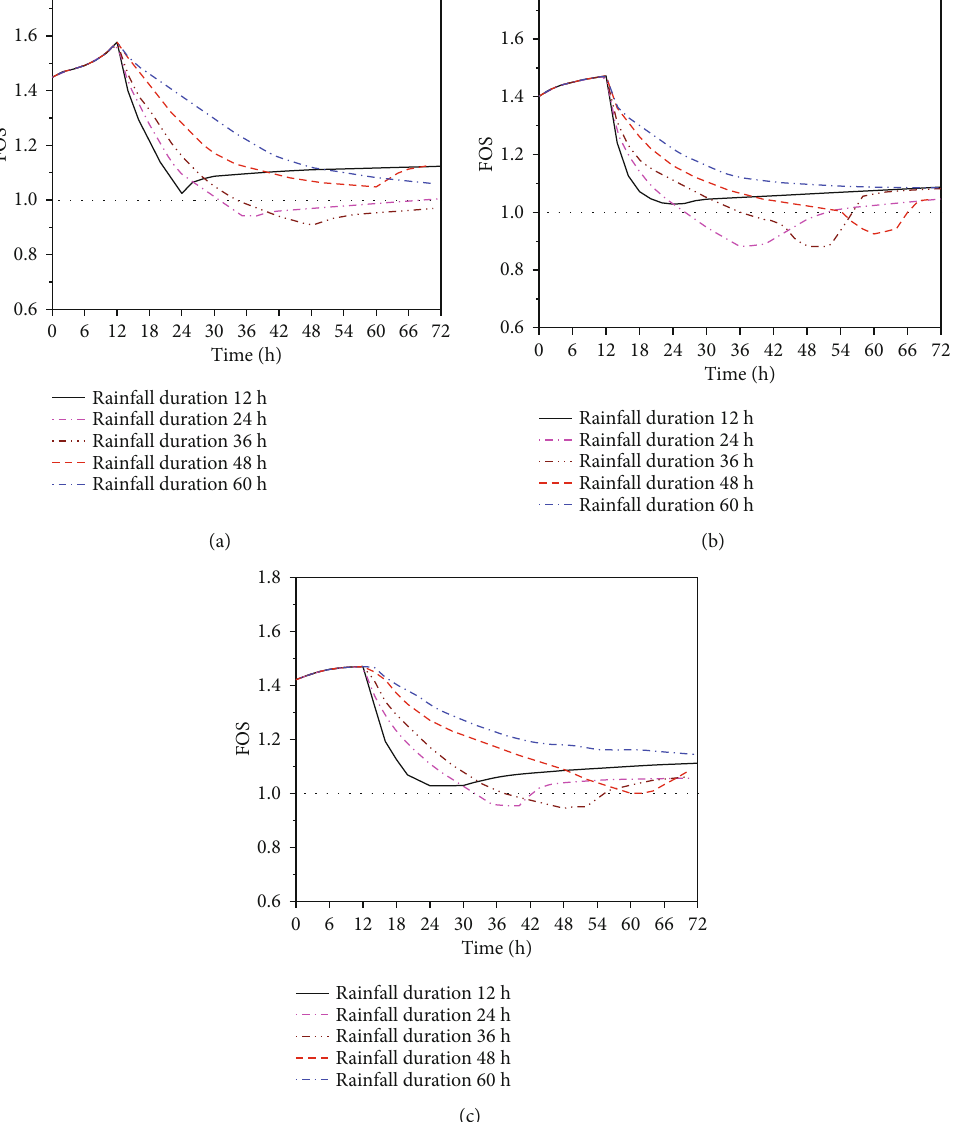
Figure 10: FOS of the VS for the rainfall amount of 500mm with di ff erent root architectures: (a) oval, (b) exponential, and (c)